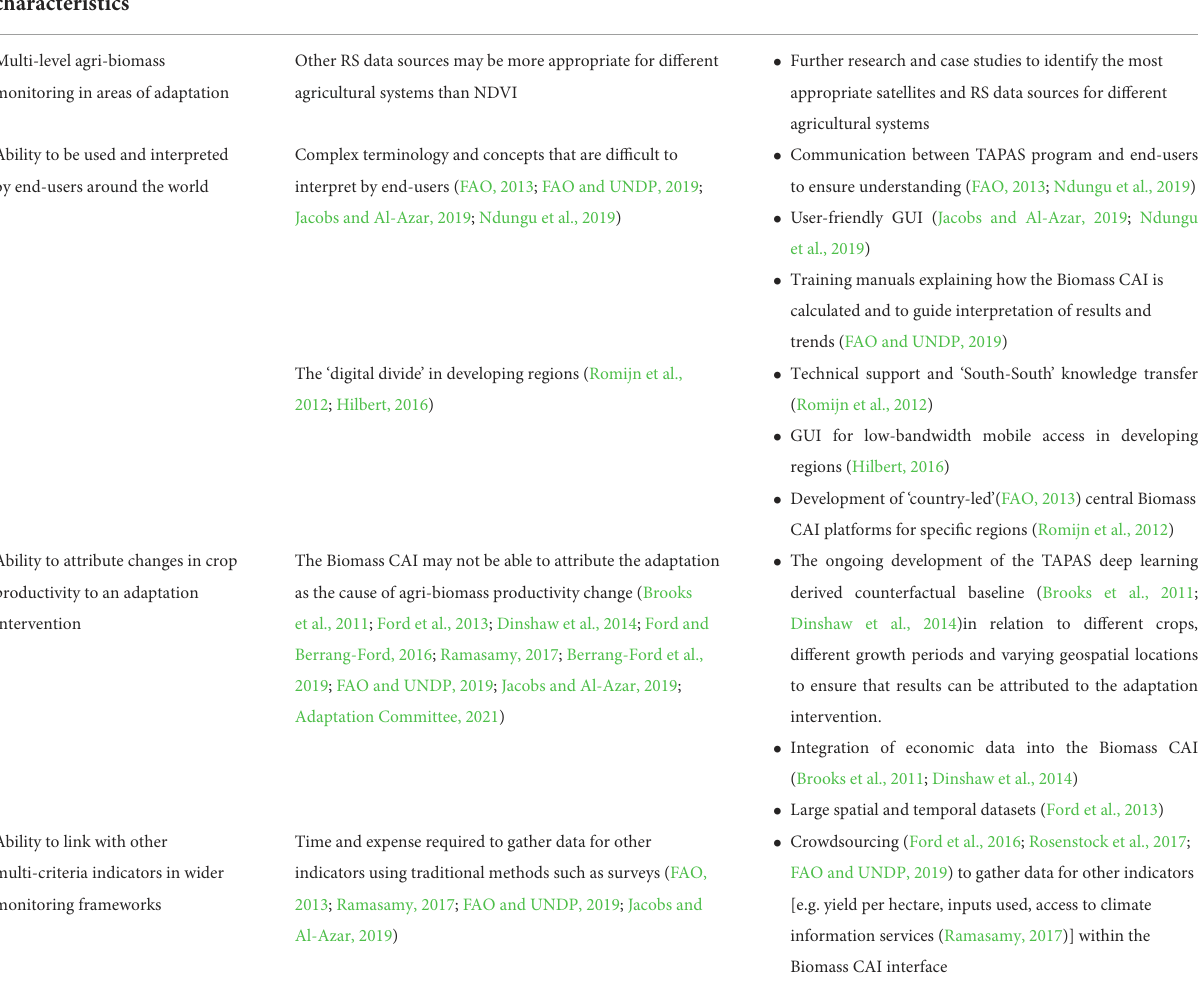
TABLE 2 Summary of characteristics needed for the Biomass CAI, barriers, and approaches to overcome such